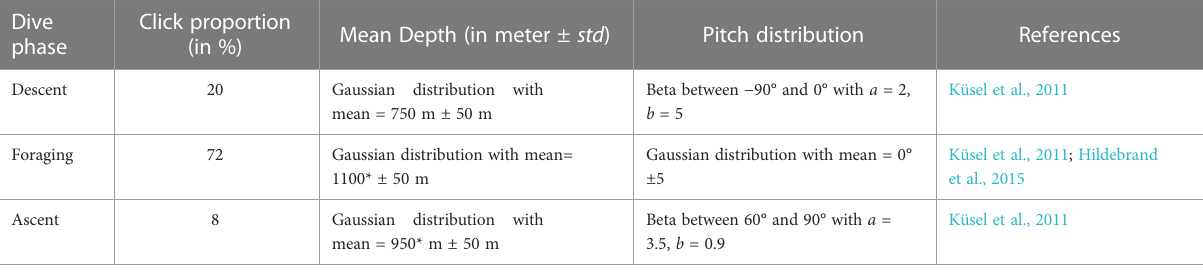
TABLE 3 Parameters to generate animal locations and orientations for the Monte Carlo